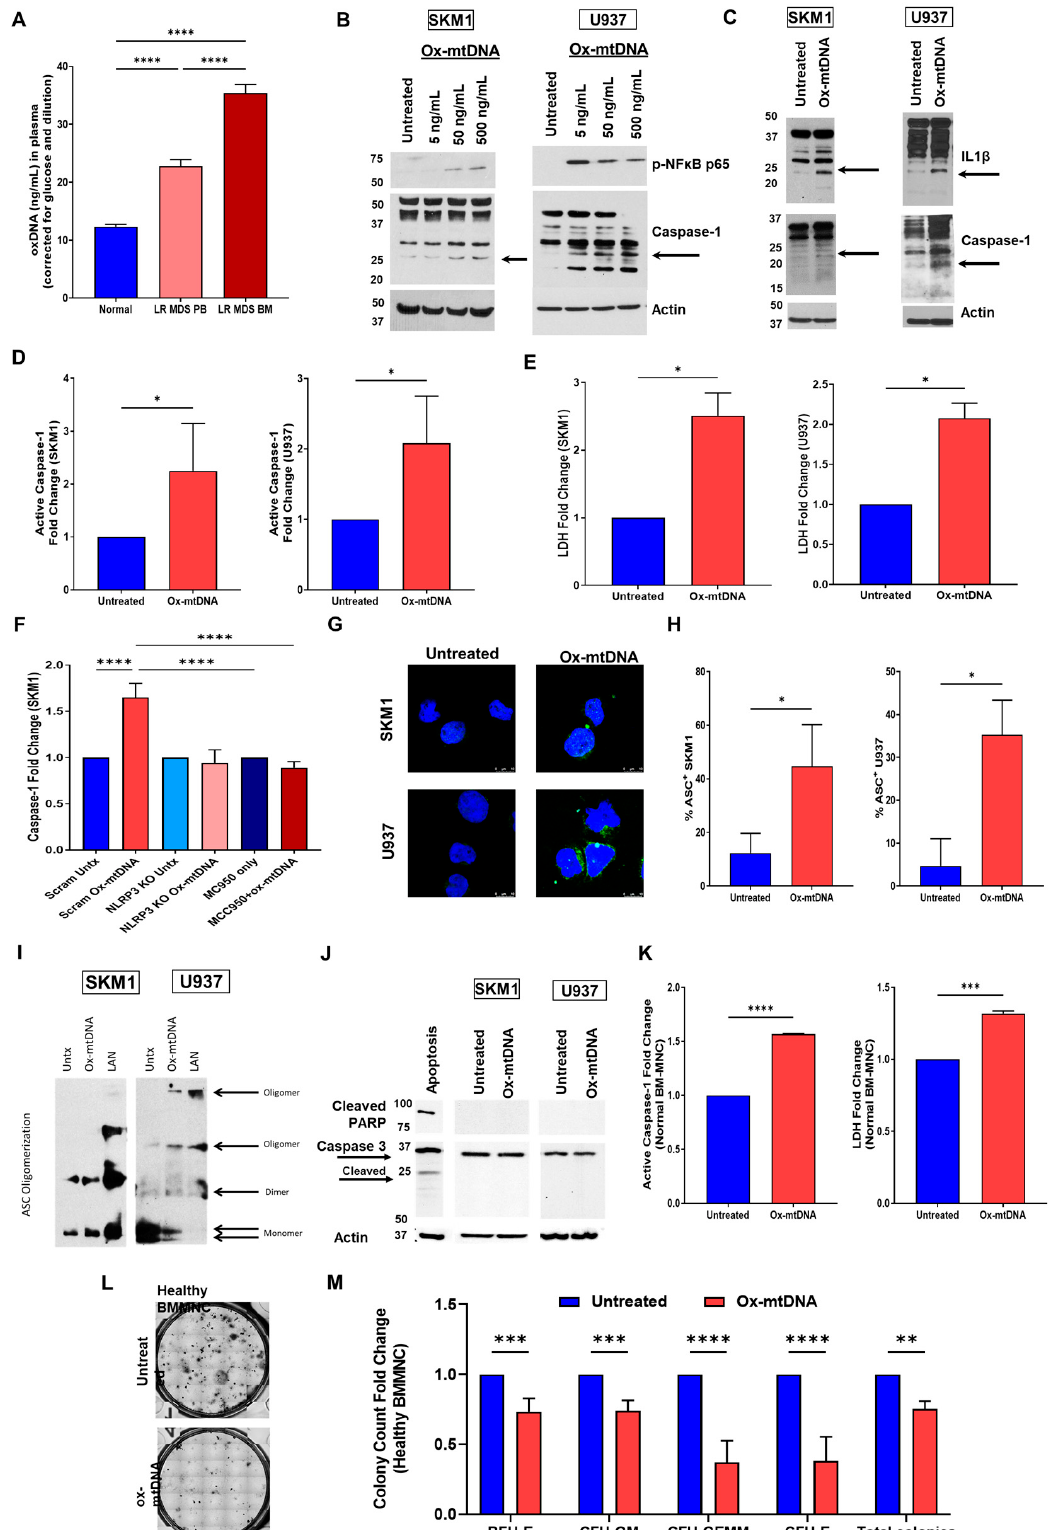
Figure 1. Ox-mtDNA activates pyroptosis. ( A ) Log10-transformed, glucose-adjusted ox-mtDNA levels from Low Risk (LR) MDS PB (n = 100) and BM plasma (n = 70), and Normal PB (n =